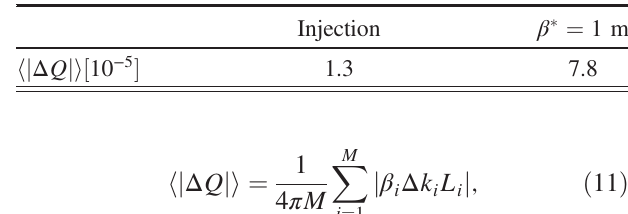
TABLE IV. Average absolute tune error produced by flux jumps in each quadrupole of IR1 and IR5.